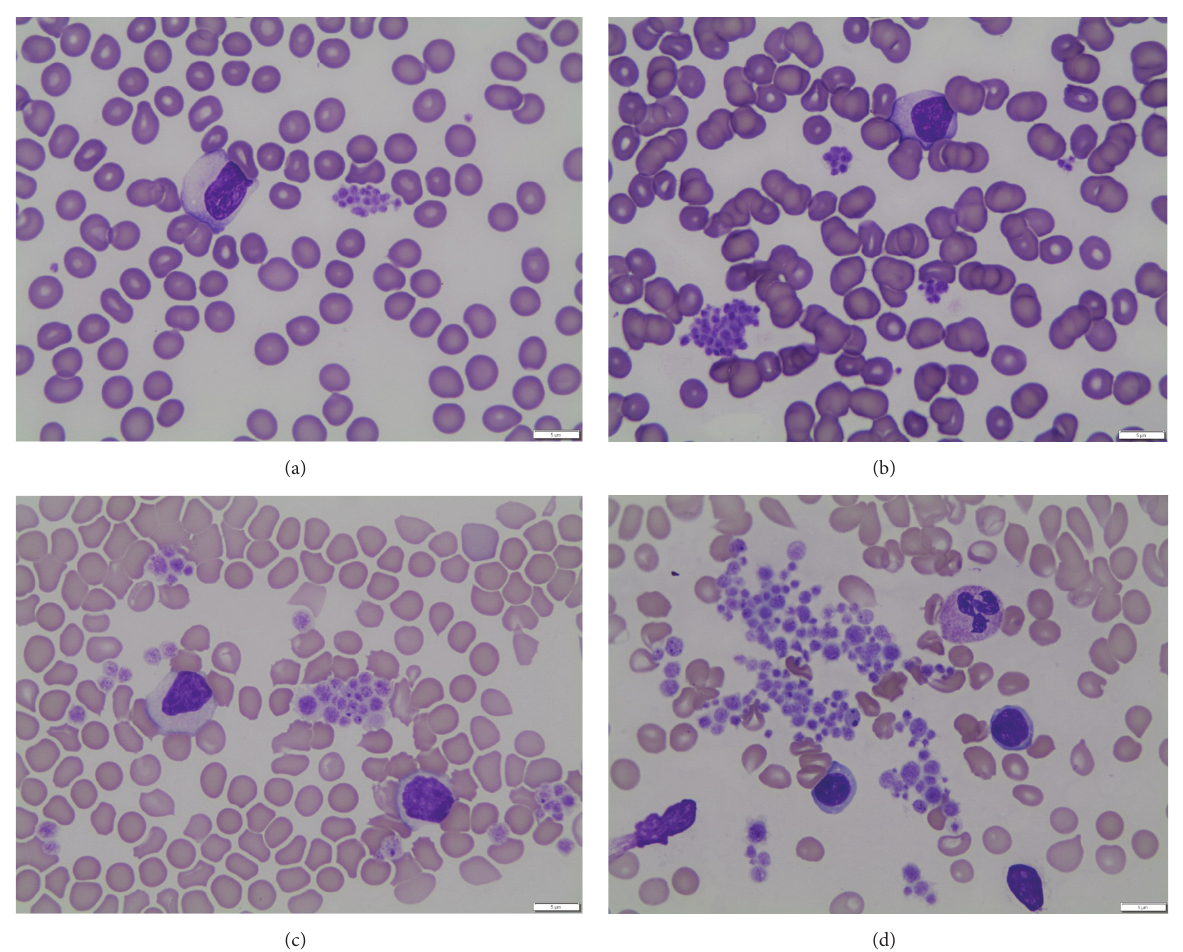
Figure 2: Platelets size and morphology of EDTA-associated clumps in (a) and (b); vWD type 2B-associated clumps in (c) and (d). Note the larger and more variable in size platelets in the latter (all photomicrographs are taken using the same 100x oil lens).